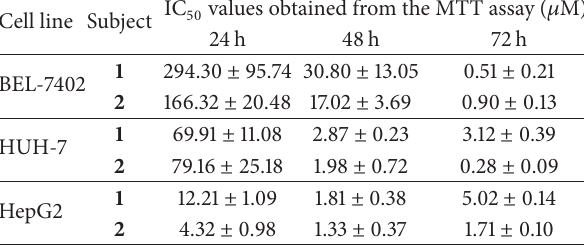
values obtained from the MTT assay Table 2: Comparison of IC 50 on BEL-7402, HUH-7, and HepG2 hepatoma cell lines after treated for 24h, 48h, and 72 h using the complexes 1 and 2